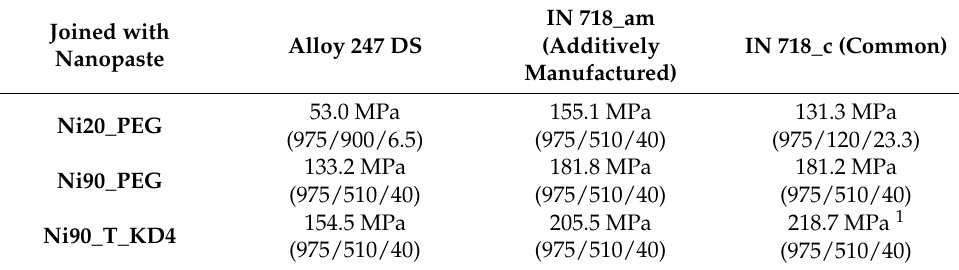
Table 4. Achieved maximum shear strengths by all base material/paste combinations. Value sets below the shear strength represent the corresponding joining parameters: T ( ◦ C)/t (s)/p (MPa). IN 718_am Joined with Alloy 247 DS (Additively IN 718_c (Common) Nanopaste Manufactured) 53.0 MPa Ni20_PEG (975/900/6.5)